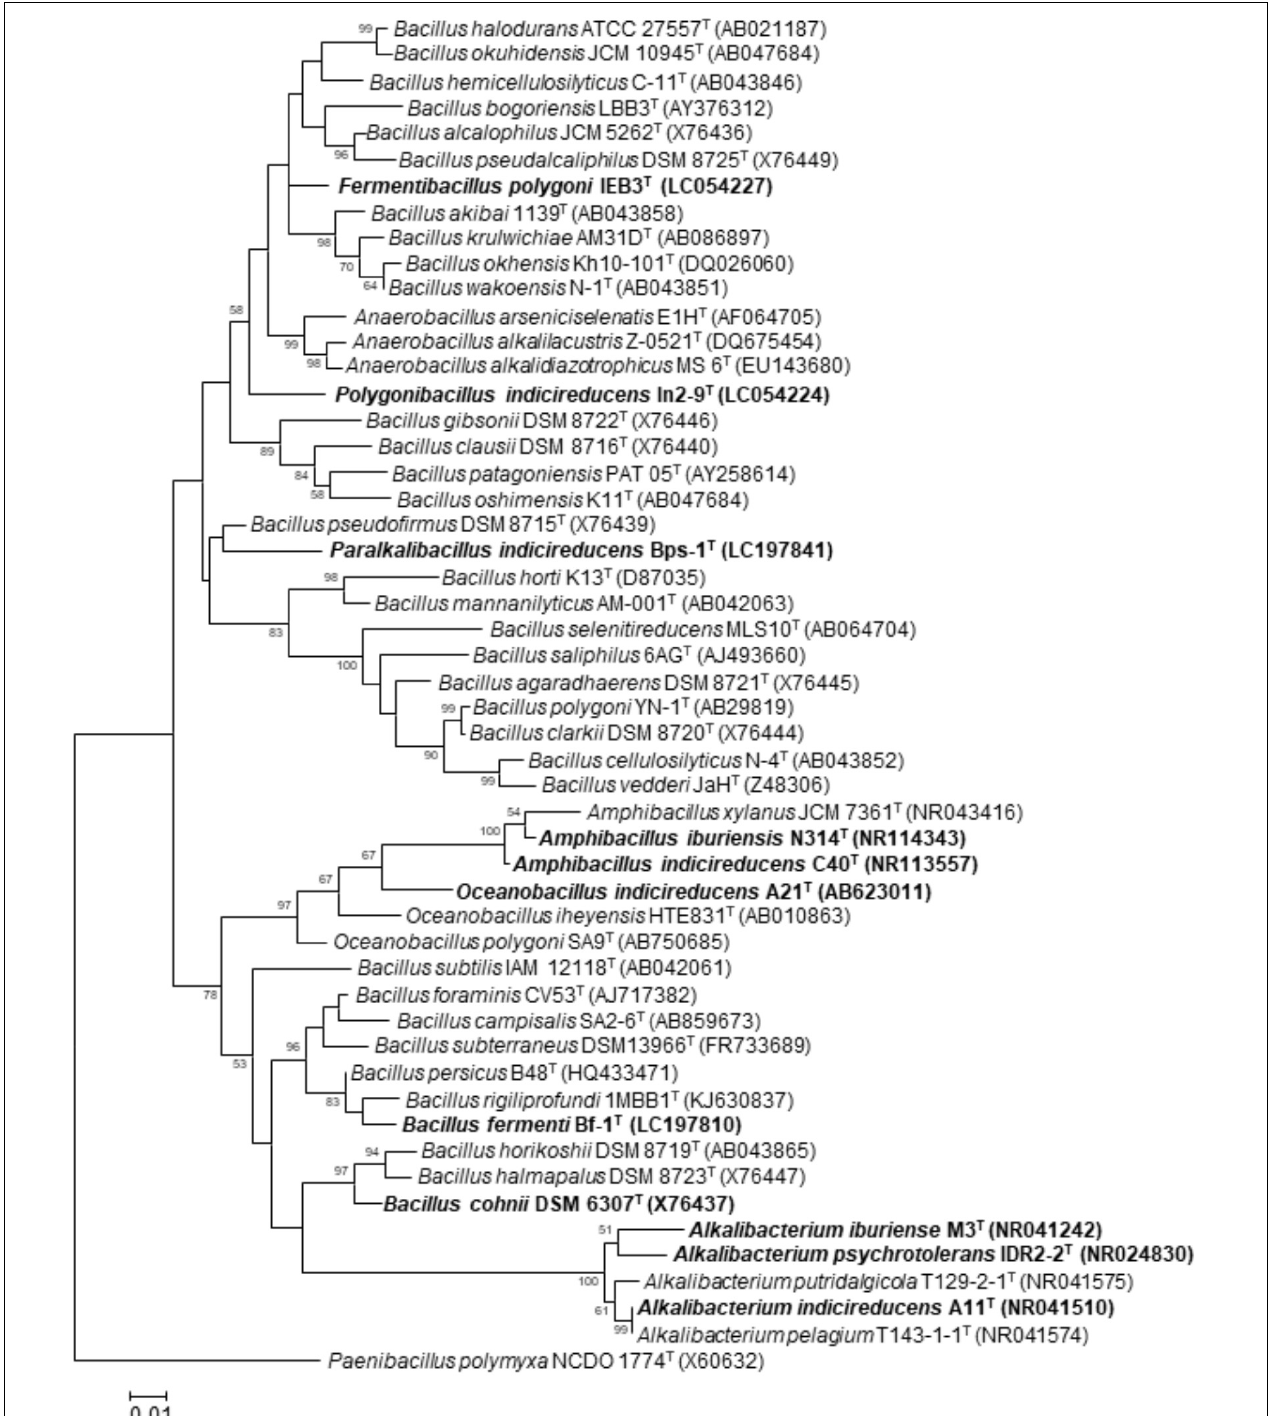
FIGURE 4 | Maximum-likelihood phylogenetic tree derived from 16S rRNA gene sequences, showing the phylogenetic positions of the isolated indigo-reducing bacteria. To construct the phylogenetic tree, the sequences were aligned with the sequences of neighboring species, and the consensus sequence was determined by CLUSTAL W (Thompson et al., 1994). The evolutionary history was inferred by using the maximum-likelihood method (Guindon and Gascuel, 2003) in MEGA 7 (Kumar et al., 2016). The evolutionary distance matrix was calculated by using Kimura’s two-parameter model (Kimura, 1980). Bold letters indicate the indigo-reducing bacteria. Although B. cohnii DSM 6307 T was not one of our isolates, strains belonging to this species that reduced indigo were isolated from indigo fermentation fluid. Bootstrap percentages (based on 1000 replicates) > 50% are shown at branch points. Scale bars = 0.01 substitutions per nucleotide position.